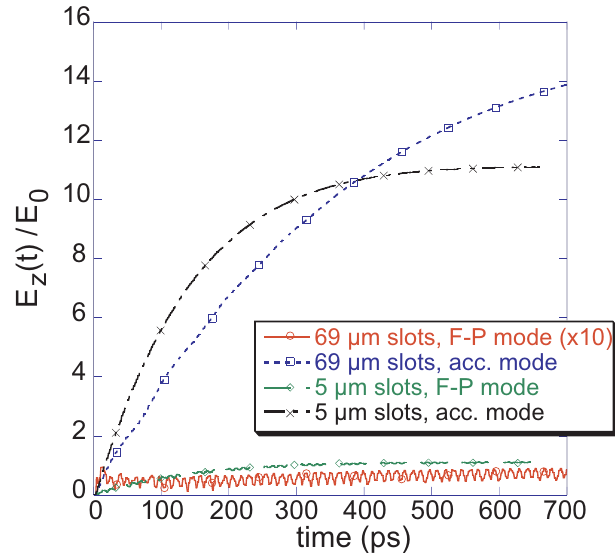
FIG. 6. (Color) Time history of electric field amplitudes for the accelerating (speed-of-light) mode and the Fabry-Perot (zero) mode, comparing the two structure designs from Fig. 5. All fields are normalized to the amplitude of the driving radiation.